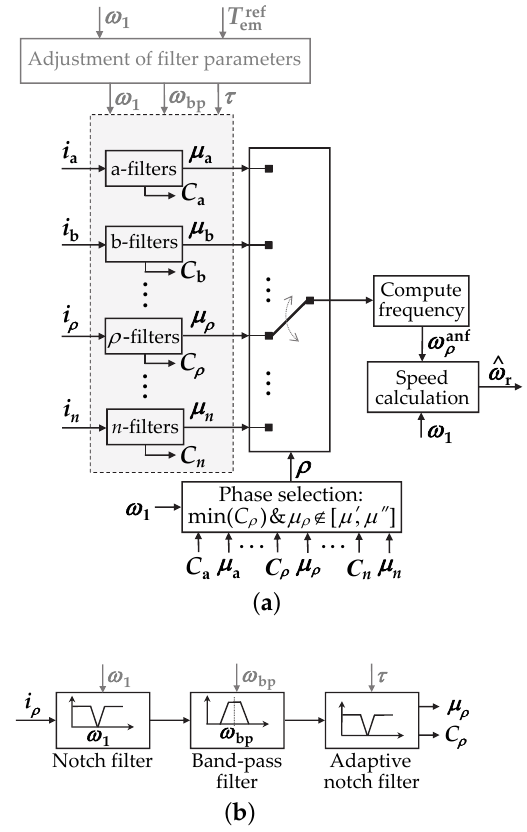
Figure 23. Speed estimation method based on rotor-slot harmonics due to fundamental current, suitable for phase OC faults [214]. ( a ) General view. ( b ) Set of filters in an arbitrary phase ρ